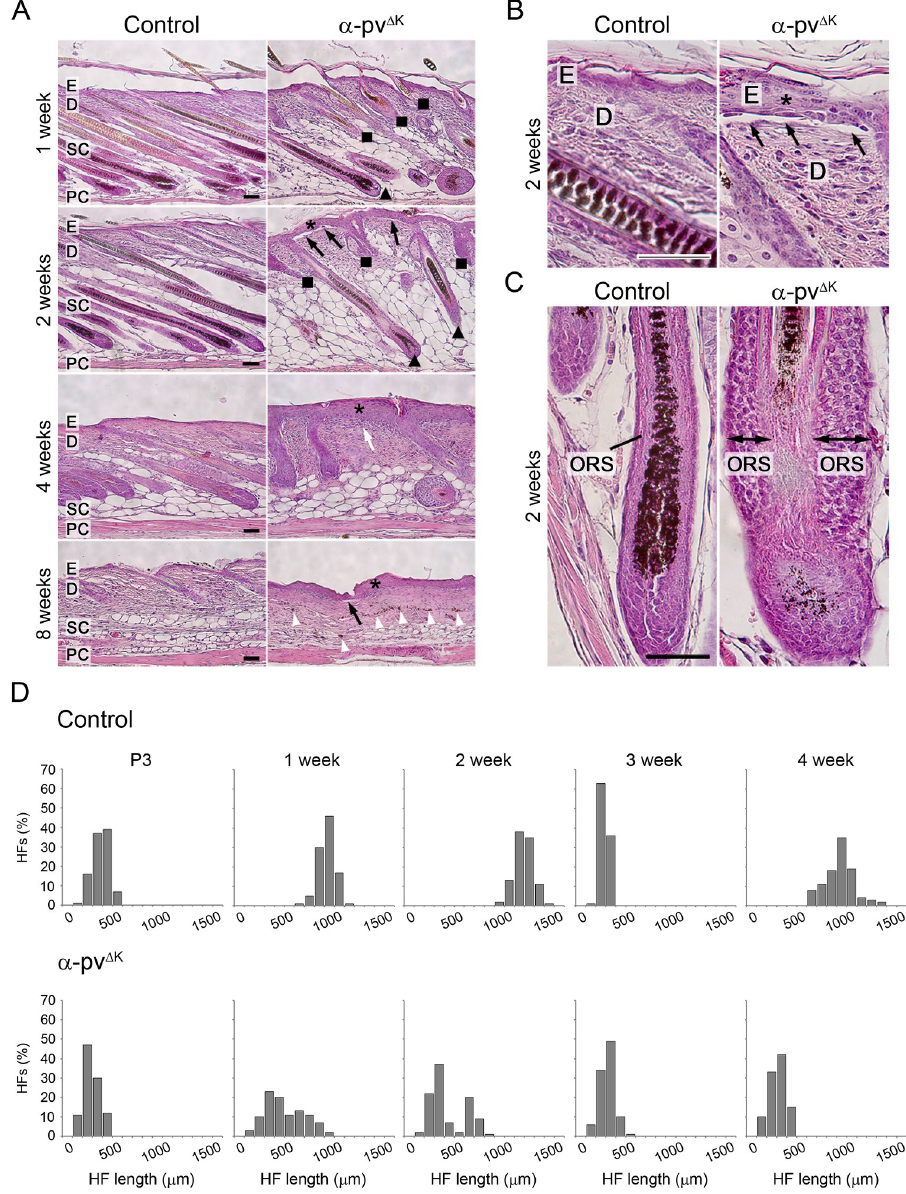
Fig 2. Keratinocyte-restricted deletion of α -pv results in epidermis thickening and subepidermal blistering and impaired HF development. ( A-C ) Hematoxylin-eosin staining of back skin section of control and α -pv Δ K mice. Black arrows indicate areas of epidermal detachments at the DEJ, white arrow indicate subepidermal blister filled with repair tissue, white arrowheads indicate abnormal melanin-deposits. Triangle: fully developed HFs, square: short and prematurely growth arrested HFs and asterisk: epidermis hyperthickening. E: epidermis; D: dermis; SC: subcutis; PC: panniculus carnosum. Scale bar: 200 μ m. ( D ) Histogram of HF length distributions at distinct stages of the HF cycle. At least 3 mice per genotype and time point were analyzed, and a minimum of 100 HFs per time point are presented in the histograms. Images were processed with the Image-J software.